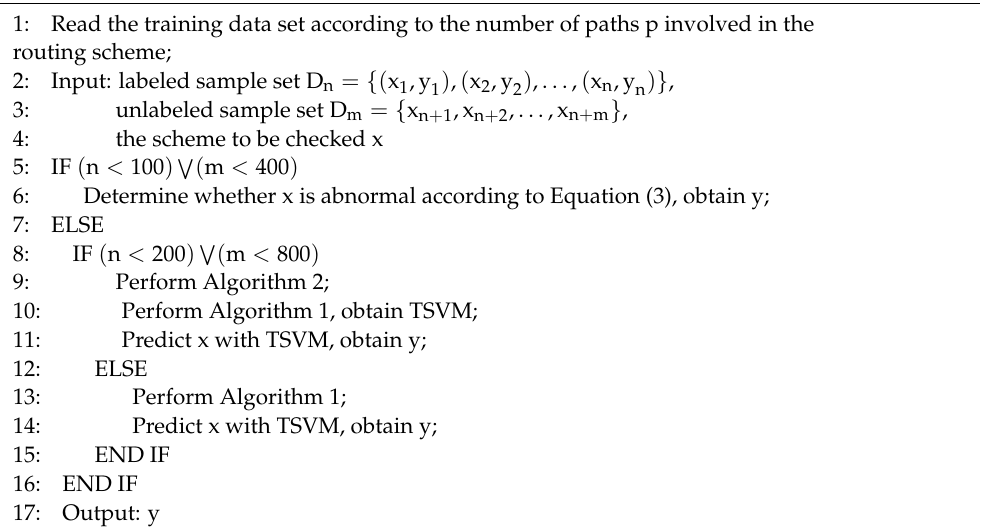
Algorithm 3: Real-time evaluation algorithm based on semi-supervised learning (RESL)